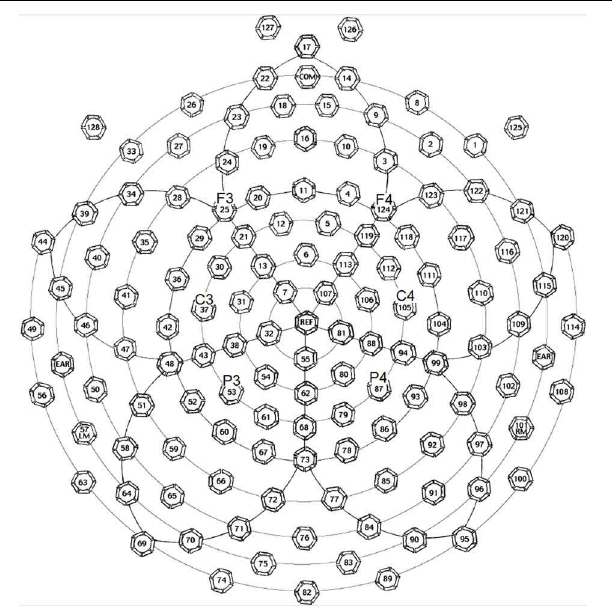
FIGURE 1 | Electrode positions of the EGI 128-channel Geodesic Sensor Net, in which the key electrodes (F3, F4, C3, C4, P3, and P4) for forming electrode groups to trace interested ERP waveforms and components are marked. This figure is available at: ftp.egi.com/pub/